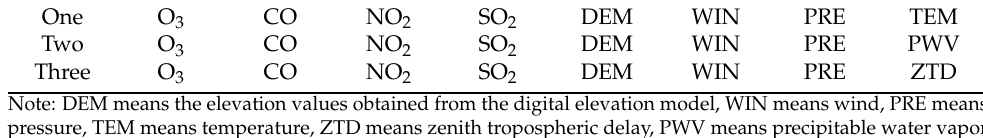
Table 2. Variable Combination Scheme.